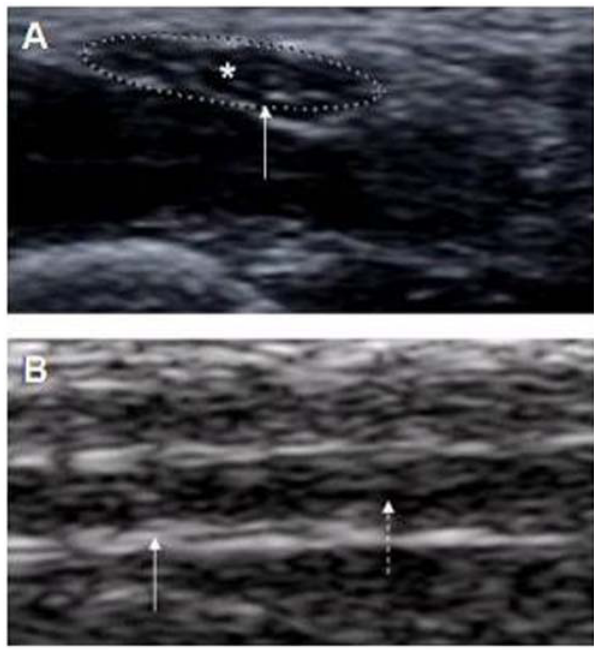
Figure 1. Ultrasonography and color Doppler images of peripheral nerves of healthy subjects. A Transverse scan of medial nerve from a healthy subject as denoted by dotted ellipse (CSA=4.5 mm 2 ) showing hypoechoic fascicles separated by hyper- echoic areas in a ‘honeycomb’ like pattern with absence of blood flow signals; B longitudinal ultra sonogram of ulnar nerve from a healthy subject (arrows) with hyperechogenic bands in a linear pattern appearing as bundles of straw.